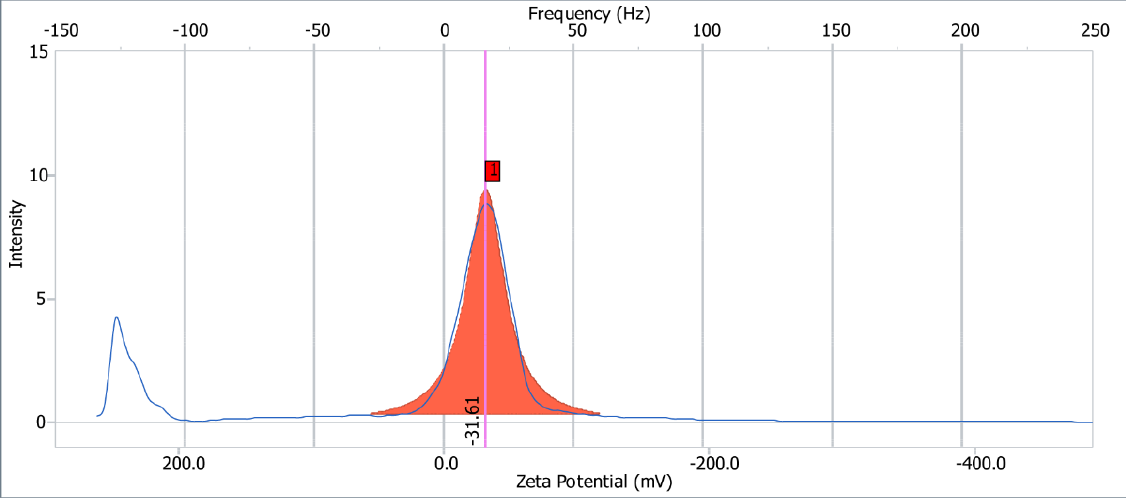
Figure 6. Zeta potentials of PF40.